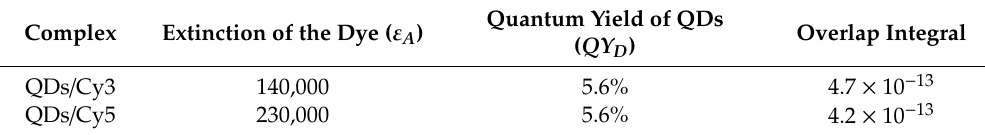
Table 1. The values of the quantities for Equation (1).